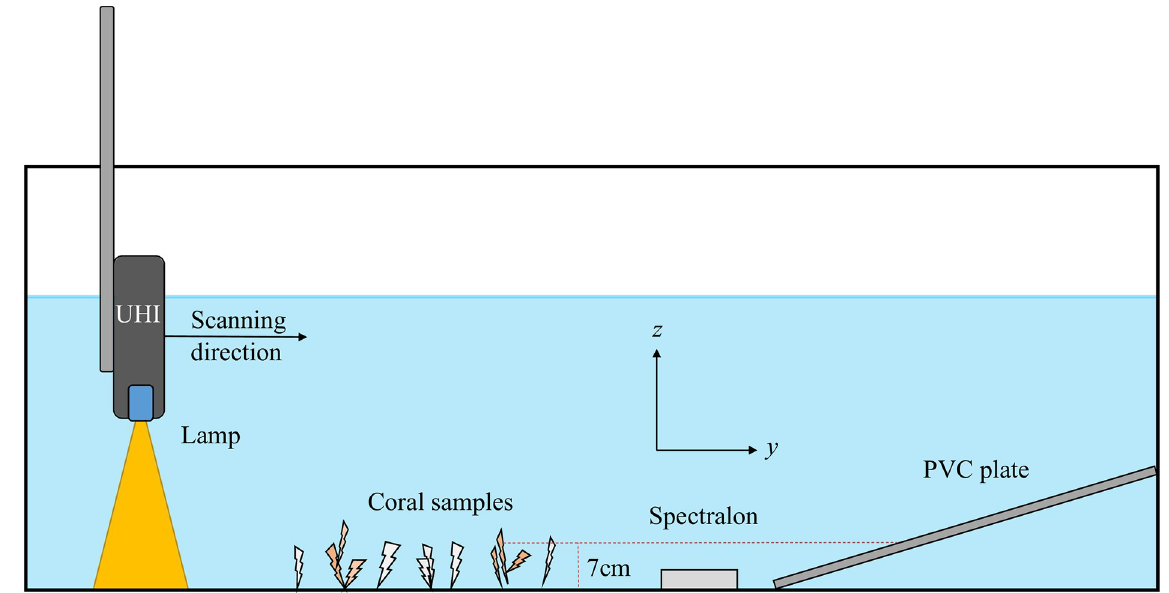
Fig 3. Experimental setup for UHI image acquisition. Samples of L. pertusa were set up on the bottom of a tank and imaged using an underwater hyperspectral imager (UHI). The UHI was attached to a linear scanning mechanism and operated in a “push-broom” fashion. The setup also includes a Spectralon reference plate and an inclined reference plate to account for changes in the spectrum due to the presence of water.